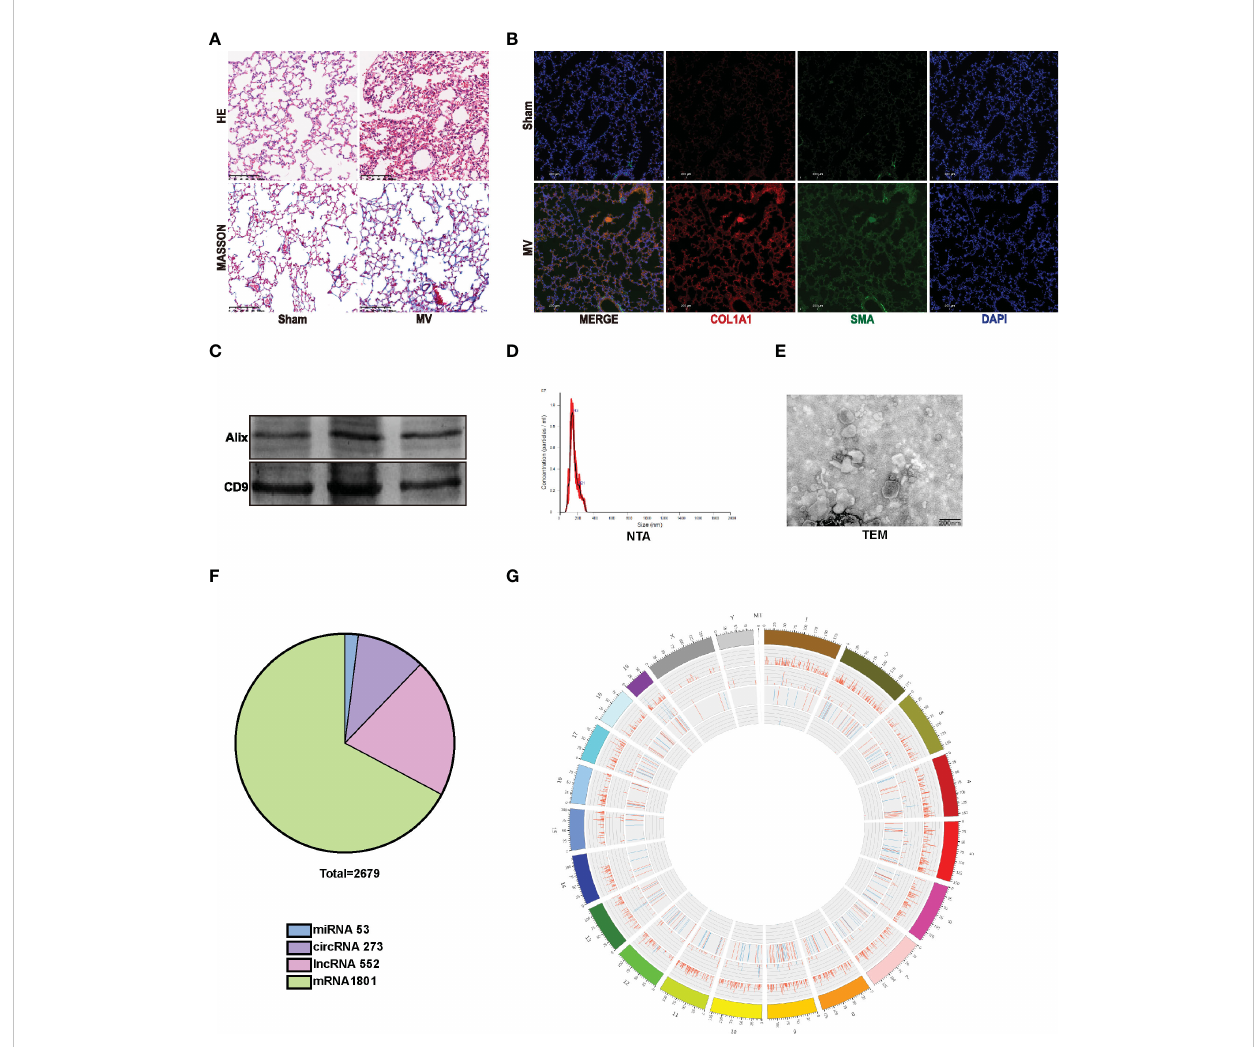
FIGURE 1 MV-induced pulmonary fi brosis accompanied by EV release. (A) lung injury was accessed by Hematoxylin and Eosin staining. Collagen deposition was assessed by Masson ’ s trichrome staining. Original magni fi cation ×200. Scale bars correspond to 100 m m (n = 6). (B) lung tissues were stained with fl uorophore-labeled antibodies against COL1A1(Alexa Fluor 594, red), a -SMA (Alexa Fluor 488, green) and nuclei (Alexa Fluor 405, blue) stain by 4 ’ ,6-diamidino-2- phenylindole (DAPI). Original magni fi cation ×200. Scale bars correspond to 100 m m (n = 6). (C – E) . EV isolated from BALF were determined by WB, NTA and TEM. (F) Pie diagram showed the content of the differentially expressed RNAs. (G) circus diagram showed the expression level of differentially expressed RNAs according to the location